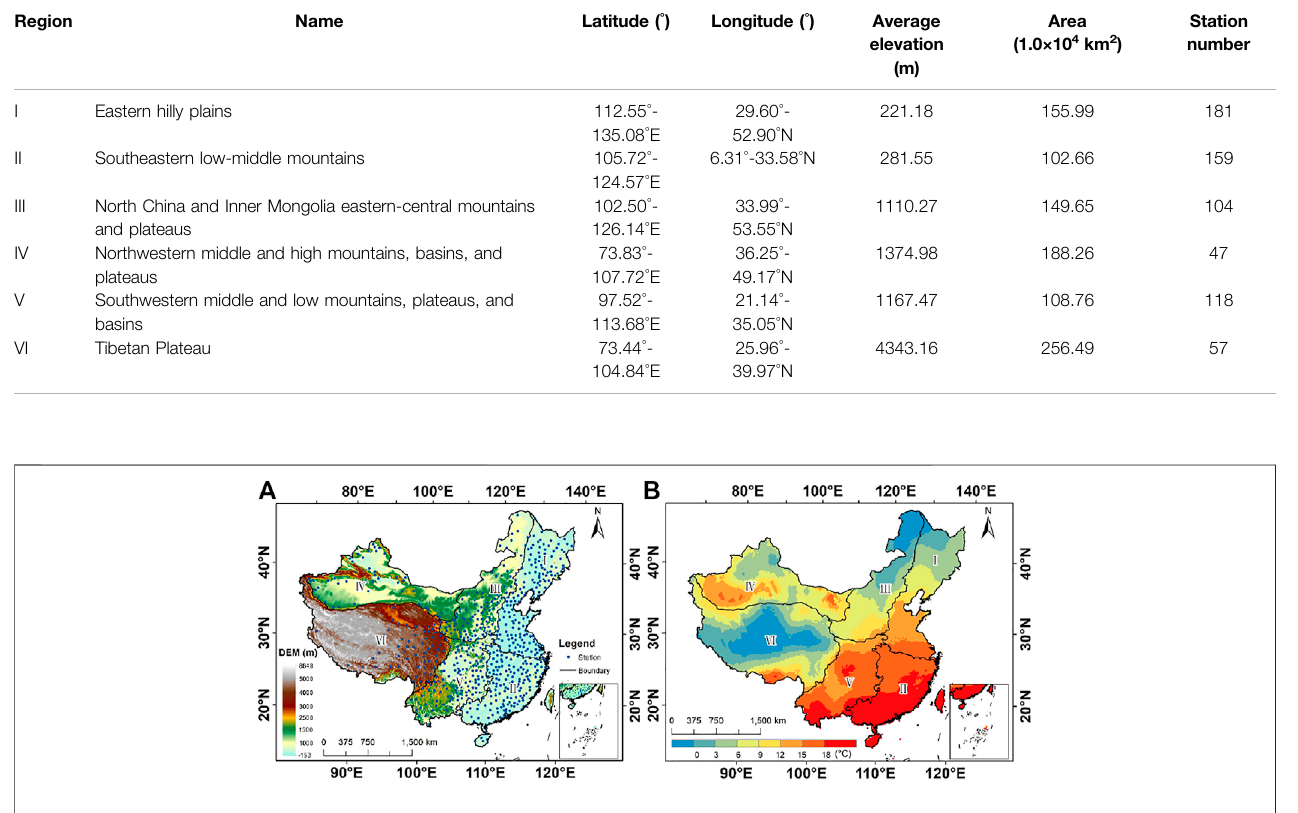
TABLE 1 | Geomorphological regionalization information.